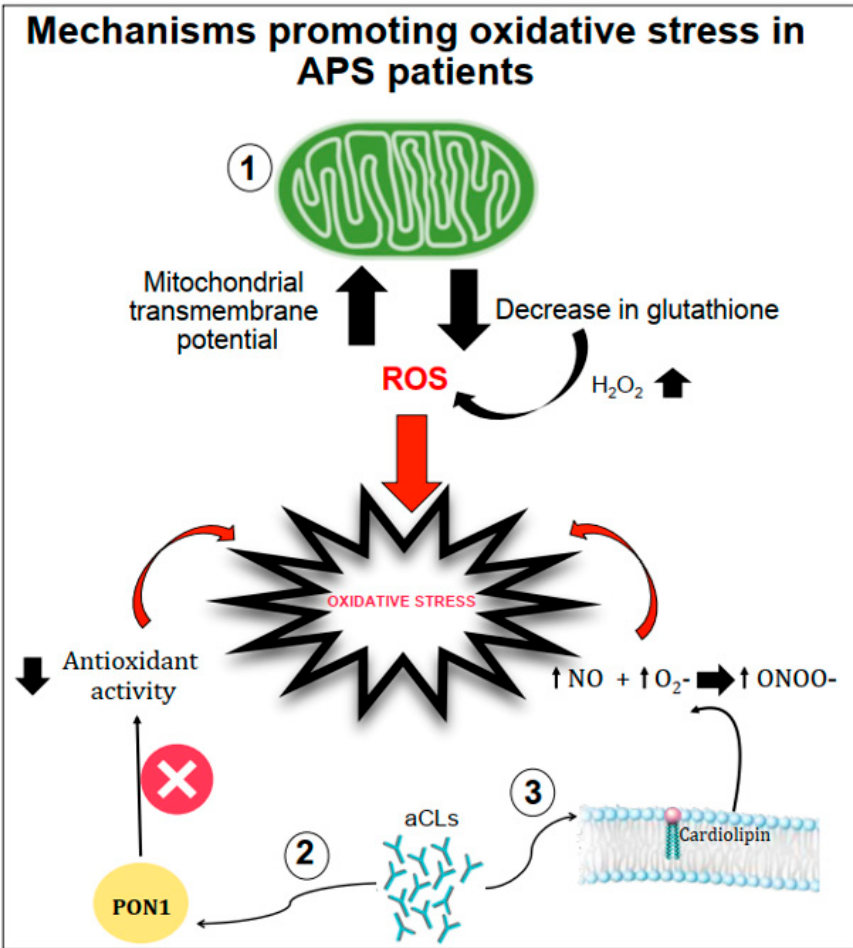
Figure 1. Schematic representation of mechanisms promoting oxidative stress in APS patients. Oxidative stress can be favoured by (1) the increase in the mitochondrial transmembrane potential and the decrease in intracellular glutathione contents; (2) the interactions between anticardiolipin antibodies (aCL) and the paraoxonase-1 (PON1) limiting its antioxidant properties; (3) aCL induction of nitric oxide (NO) and superoxide (O 2 − ) production with increased levels of peroxynitrite (ONOO − ) a pro-oxidant